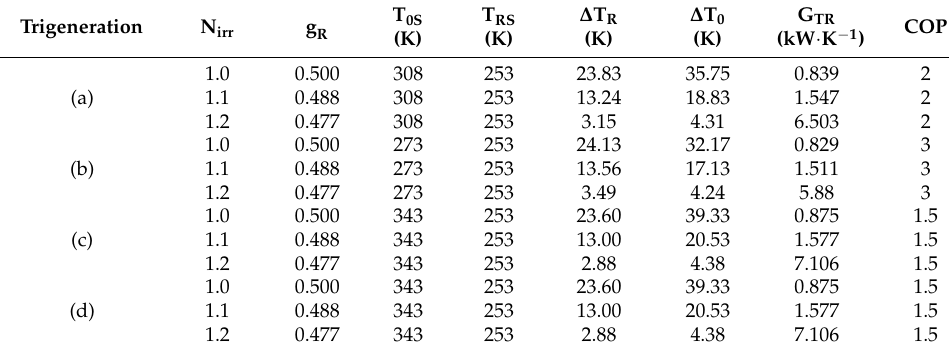
Table 2. External parameters for the refrigeration unit,